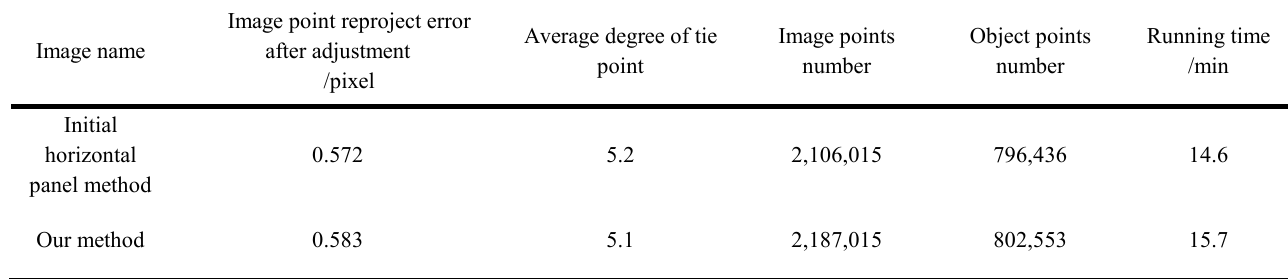
Table6. Matching results and matching efficiency comparisons of smooth area tilted